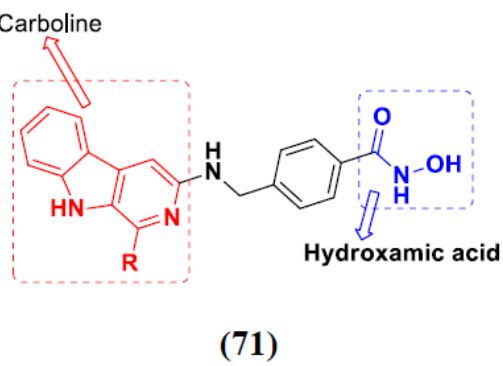
Figure 68. Structure of hydroxamate- β -carboline based hybrid derivatives ( 71 ). Table 56. In vitro cytotoxic activities of hydroxamate- β -carboline based hybrid compounds 71 ( a – d ). Compounds